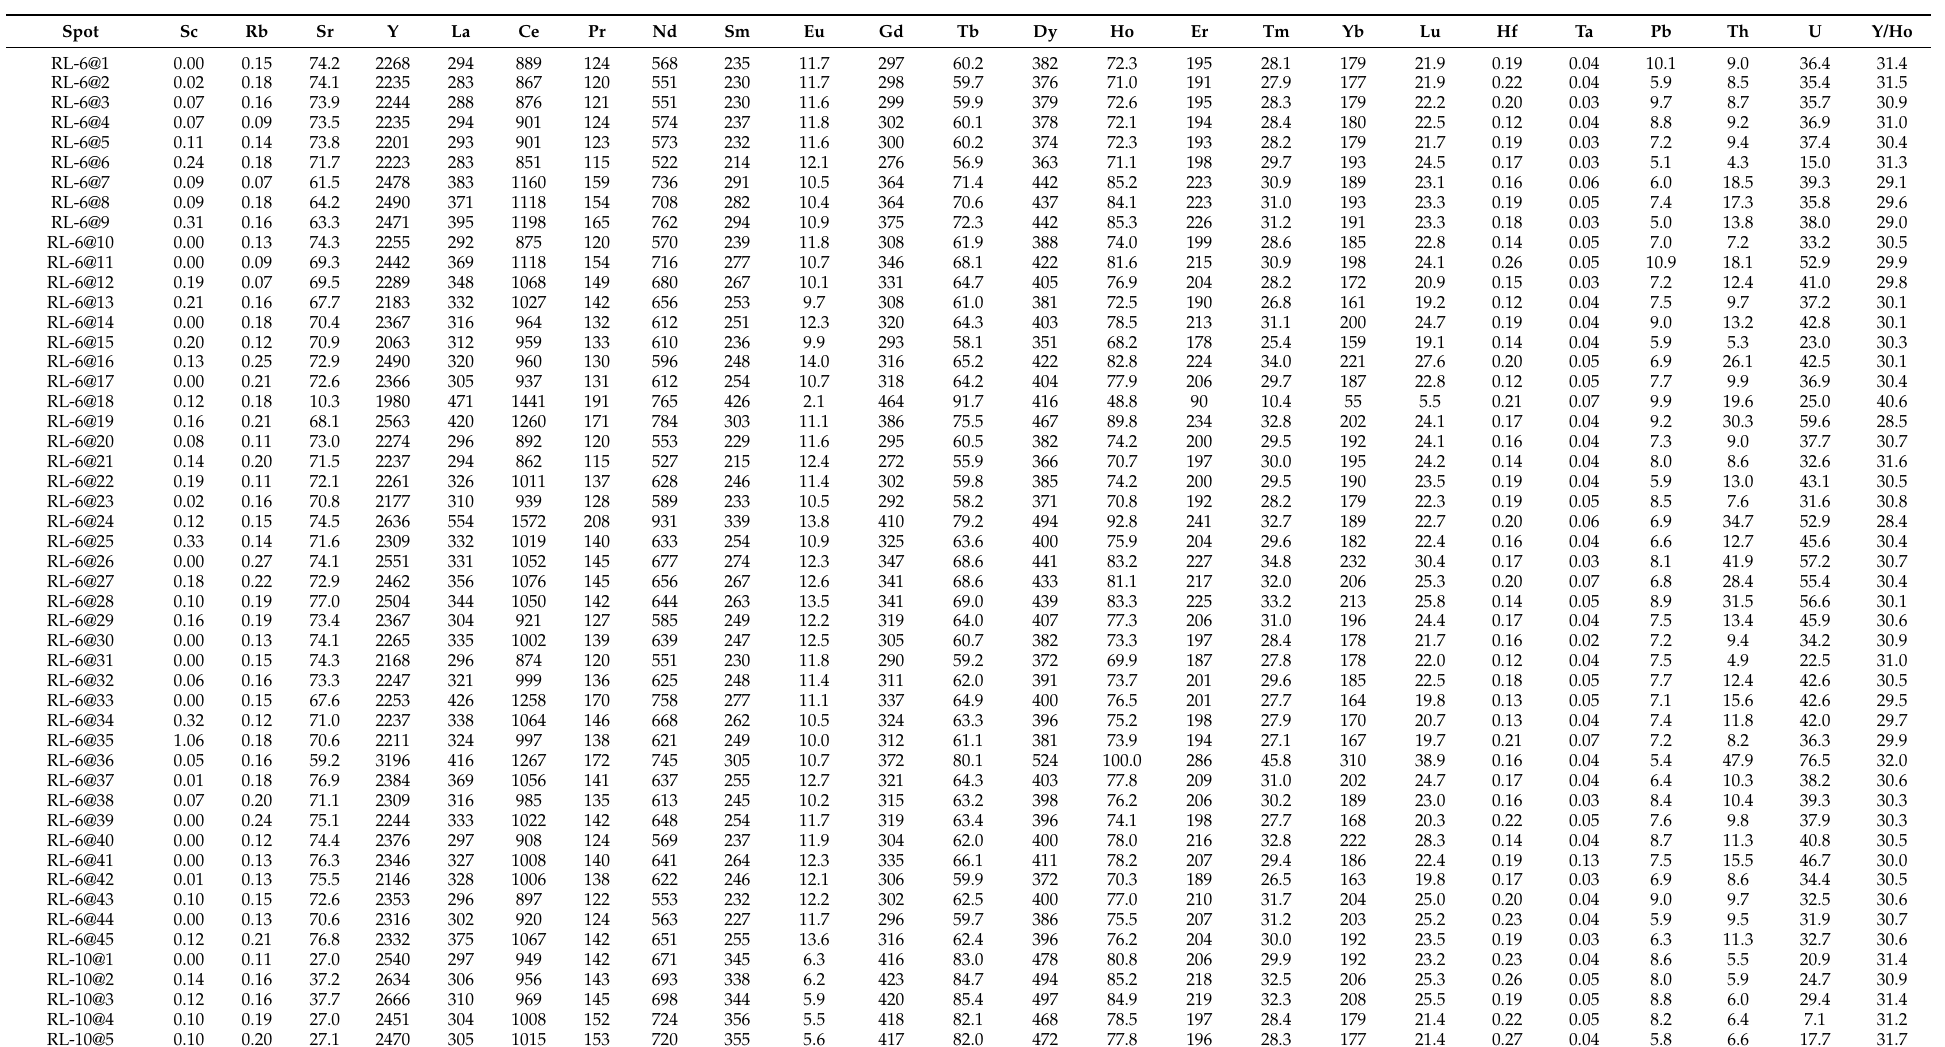
Table 4. Trace element composition for apatite of the pegmatite from the Renli Nb-Ta deposit